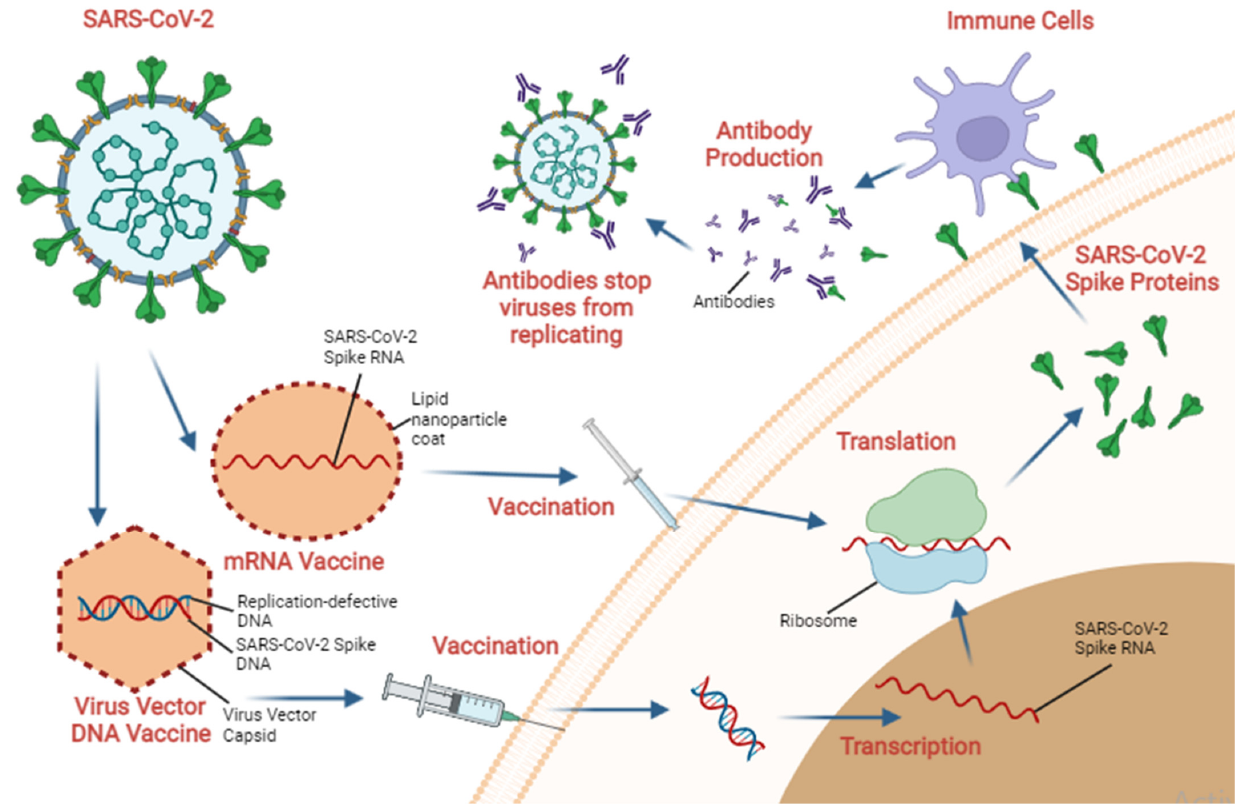
Figure 3. Schematic representation of how vaccination works. This image shows a simplified version of how the vaccine mechanism can block the SARS-CoV-2 virus from infecting a person’s body, starting with the manufacture of vaccines based on the SARS-CoV-2 virus. In this example, an mRNA vaccine contains the SARS-CoV-2 spike RNA. This RNA will be translated by the ribosome to make a spike protein, which can later be recognized by the immune system and produce antibod- ies that prevent the SARS-CoV-2 virus from replicating. There are also vaccines that use replication- defective viral vector DNA. This vaccine enters like a viral infection and then injects its DNA into the body. The body transcribes and translates it, but the spike protein is only produced later. The figure was prepared using Biorender (https://app.biorender.com; accessed on 01 February 2022). Several vaccines have been approved, and a global mass vaccination campaign is currently underway. Vaccination continues to be a critical component of the multi-layered approach required to mitigate the impact of Omicron, while also addressing Delta’s on- going circulation, as stated by the European Centre for Disease Prevention and Control